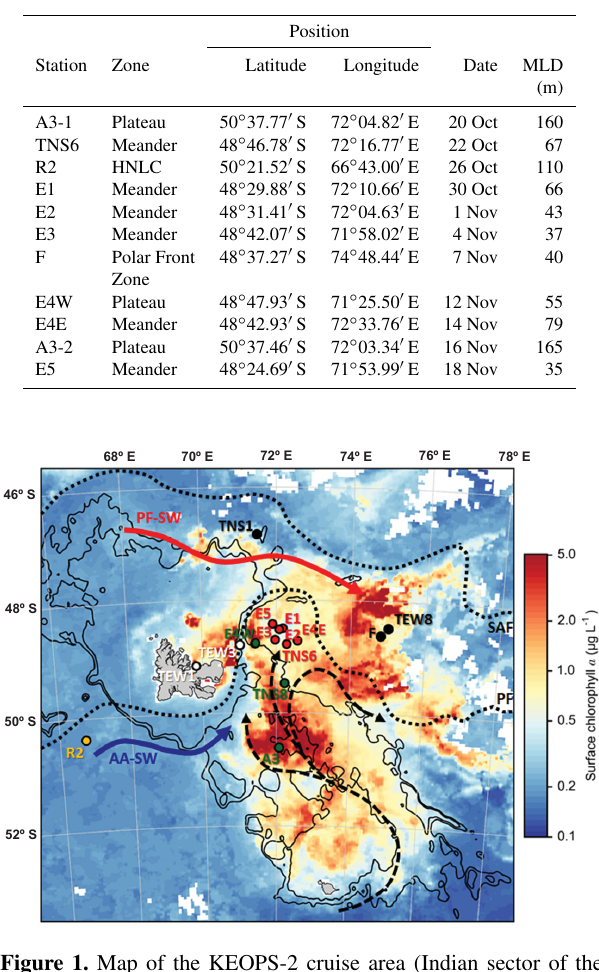
Table 1. Characteristics of the stations sampled during KEOPS-2 and discussed in this study. MLD represents the mixed-layer depth (from Park et al., 2014).